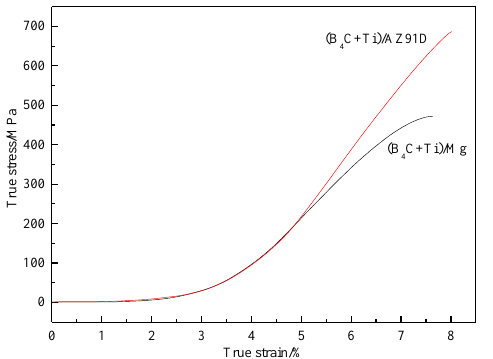
Figure 8. True stress – true strain curves of (B 4 C+Ti)/Mg and (B 4 C+Ti)/AZ91D composites prepared for 90 min.